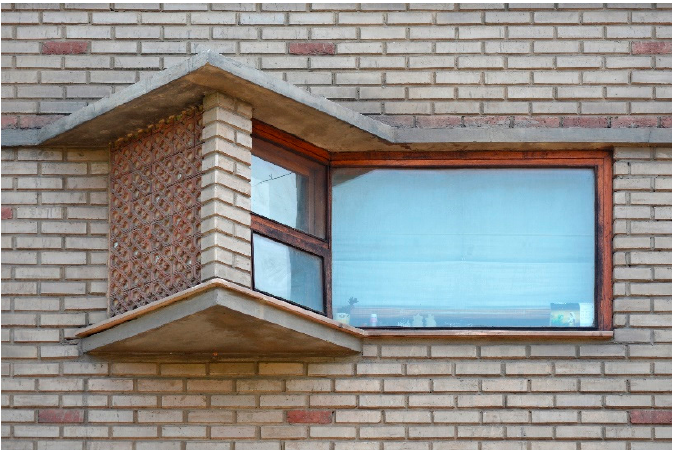
Figure 26. Window on the west façade having a prism-shaped protrusion to block the afternoon summer sun (Photo: Author).